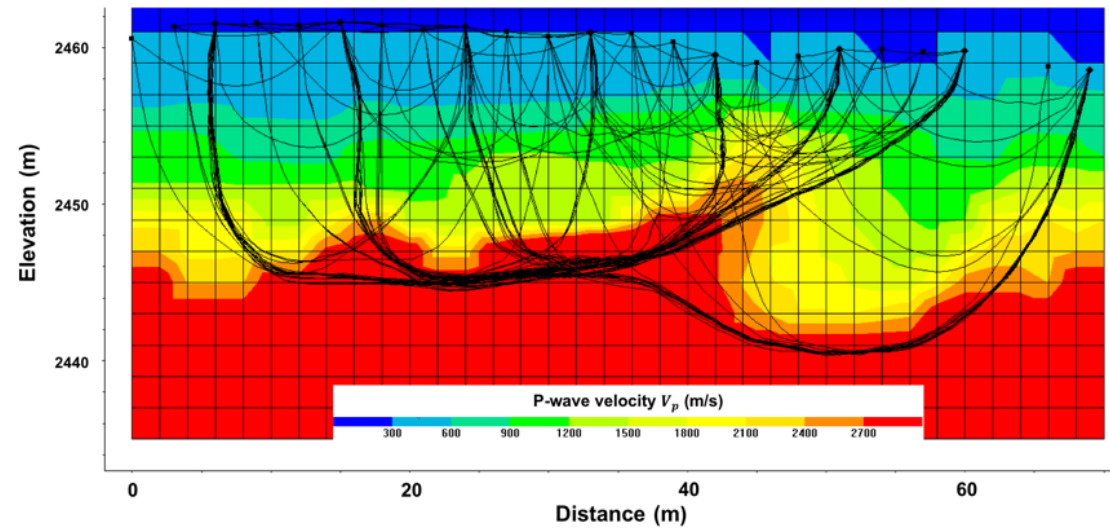
Figure D2. P-wave velocity distribution of Laurichard rock glacier, obtained from seismic tomography data acquired along the transversal profile of seismic refraction (yellow circles in Fig. 1d) in summertime. The different ray paths are shown with black curves. The seismic velocities were used to constrain bedrock depth and P-wave velocity profiles for the mechanical